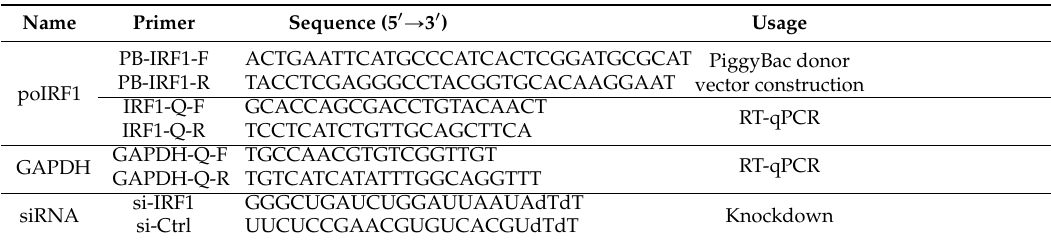
Table 1. Primers or sequences used in this